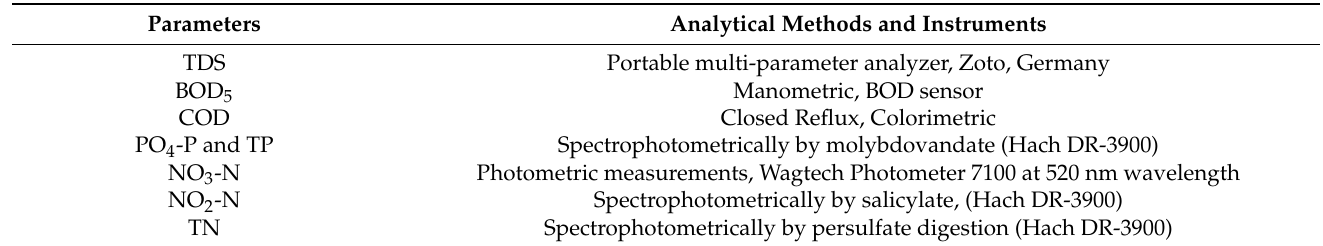
Table 4. Analytical methods and instruments used for the analysis of selected parameters in